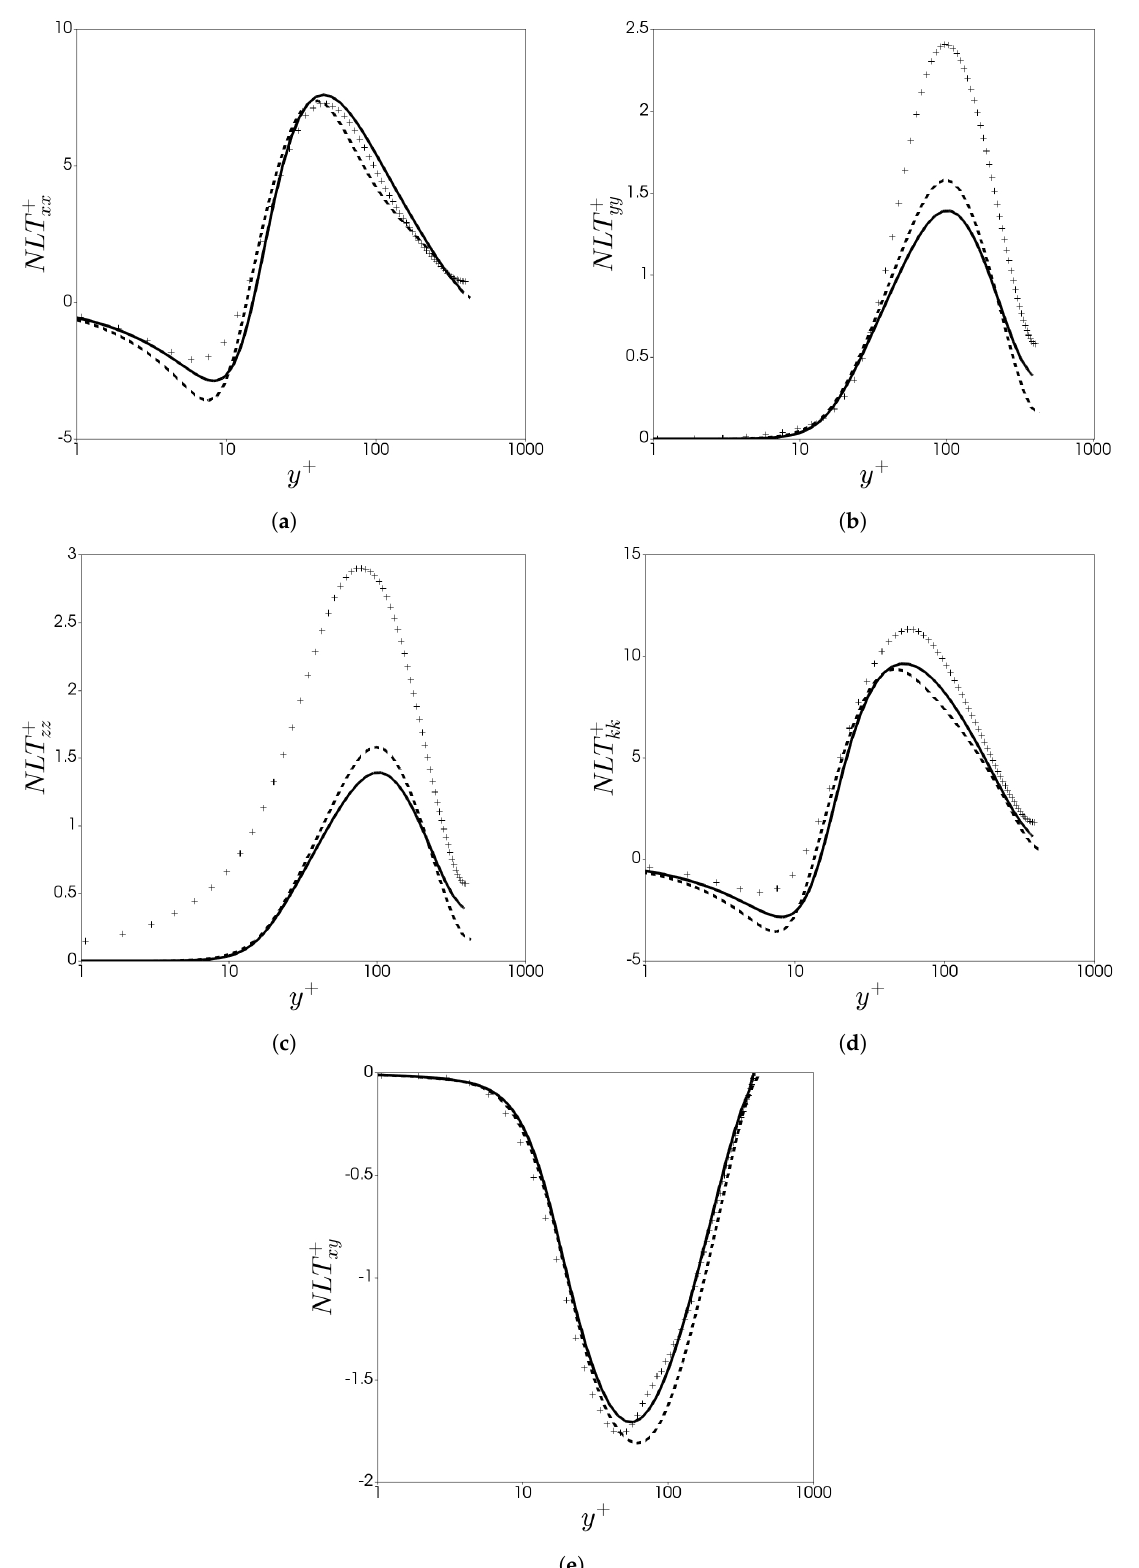
Figure 1. Comparison of the NLT ij model between DNS data (+DR = 37%, case (19)) and predictions with the new model (continuum lines), and previous model (dash lines): ( a ) NLT + xx ; ( b ) NLT + yy ; ( c ) NLT + zz ; ( d ) NLT + and ( e ) NLT + xy kk